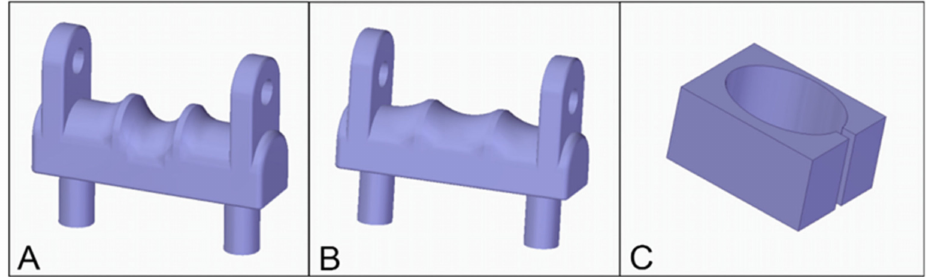
Figure 6. These 3D printed devices stabilized the models during the stress tests; ( A ) the template to the radial load; ( B ) the template to the dorsal load; ( C ) and the adapter to the torsion test. Reference for models can be found in the Appendices